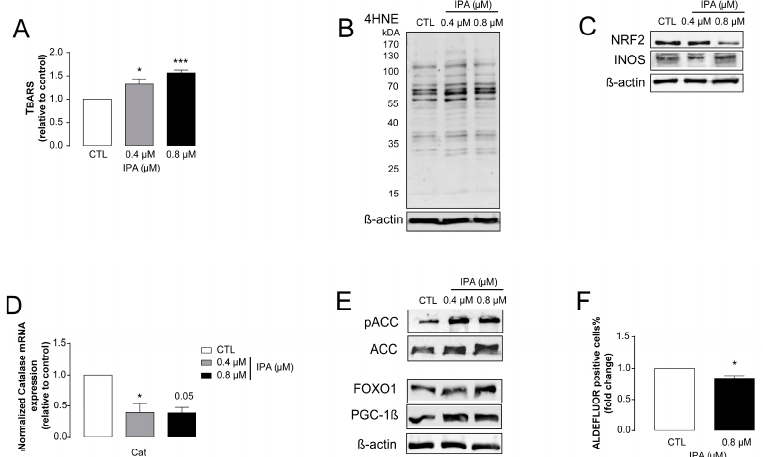
Figure 3. Indolepropionic acid (IPA) induced oxidative stress, cellular energy stress, and decreased the proportions of cancer stem cells. 500,000 cells / well 4T1 cells were treated with IPA in the concentrations indicated for 24 h; then, ( A ) lipid peroxidation was measured by TBARS assay, and ( B ) 4HNE expression was assessed by Western blotting (representative figure, n = 3). In the same cells ( C ), the protein expression of NRF2 (at 68 kDa) and iNOS were determined by Western blotting ( n = 3), while ( D ) the mRNA expression of catalase (cat) was determined by RT-qPCR ( n = 3). ( E ) The expression of the indicated proteins (pACC, ACC, FOXO1, and PGC-1 β ) were determined by Western blotting ( n = 3, except for PGC-1 β , where n = 2). ( F ) 100,000 cells / well 4T1 cells were treated with the indicated concentration of IPA for 24 h; then, the proportions of aldehyde dehydrogenase-positive cells were determined in Aldefluor assays using flow cytometry ( n = 3). For Western blots, a typical experiment was displayed. Fold data were log2 transformed to achieve normal distribution. Statistical significance was determined using the ANOVA test followed by Dunnett’s post-hoc test, except for panel F, where Student’s t -test was used. * and *** indicate statistically significant di ff erence between control and treated samples at p < 0.05 and p < 0.001,